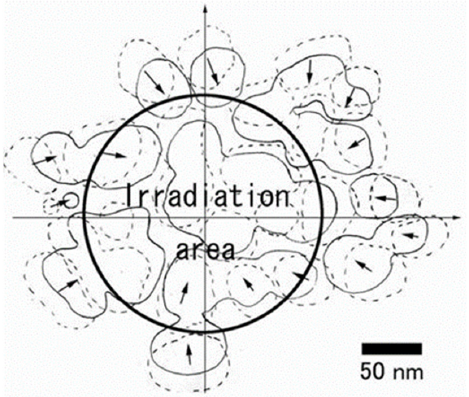
Figure 27. Superposed view of Cu nanoparticle migration and bonding during the irradiation times of 0 s (dotted line) and 30 s (solid line). The circle indicates the electron beam irradiation area of 200 nm diameter. Nanoparticles migrated toward the irradiation centre and finally bonded together. Unbonded small nanoparticles seemed to revolve clockwise around the irradiation centre [20].